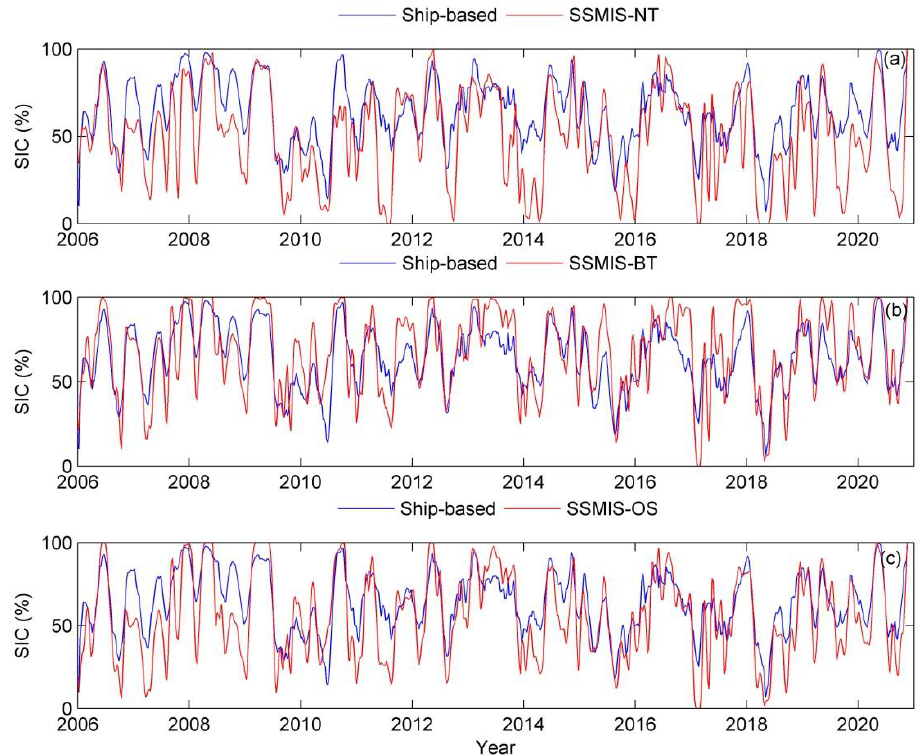
Figure 6. Pan-Arctic daily mean ship-based SIC (blue lines), for the SSMIS-NT SIC (red lines in ( a )), SSMIS-BT SIC (red lines in ( b )), and SSMIS-OS SIC (red lines in ( c )) corresponding to the ship-based observation locations for the specific cruise days. A seven-point moving average was applied to all the time series.